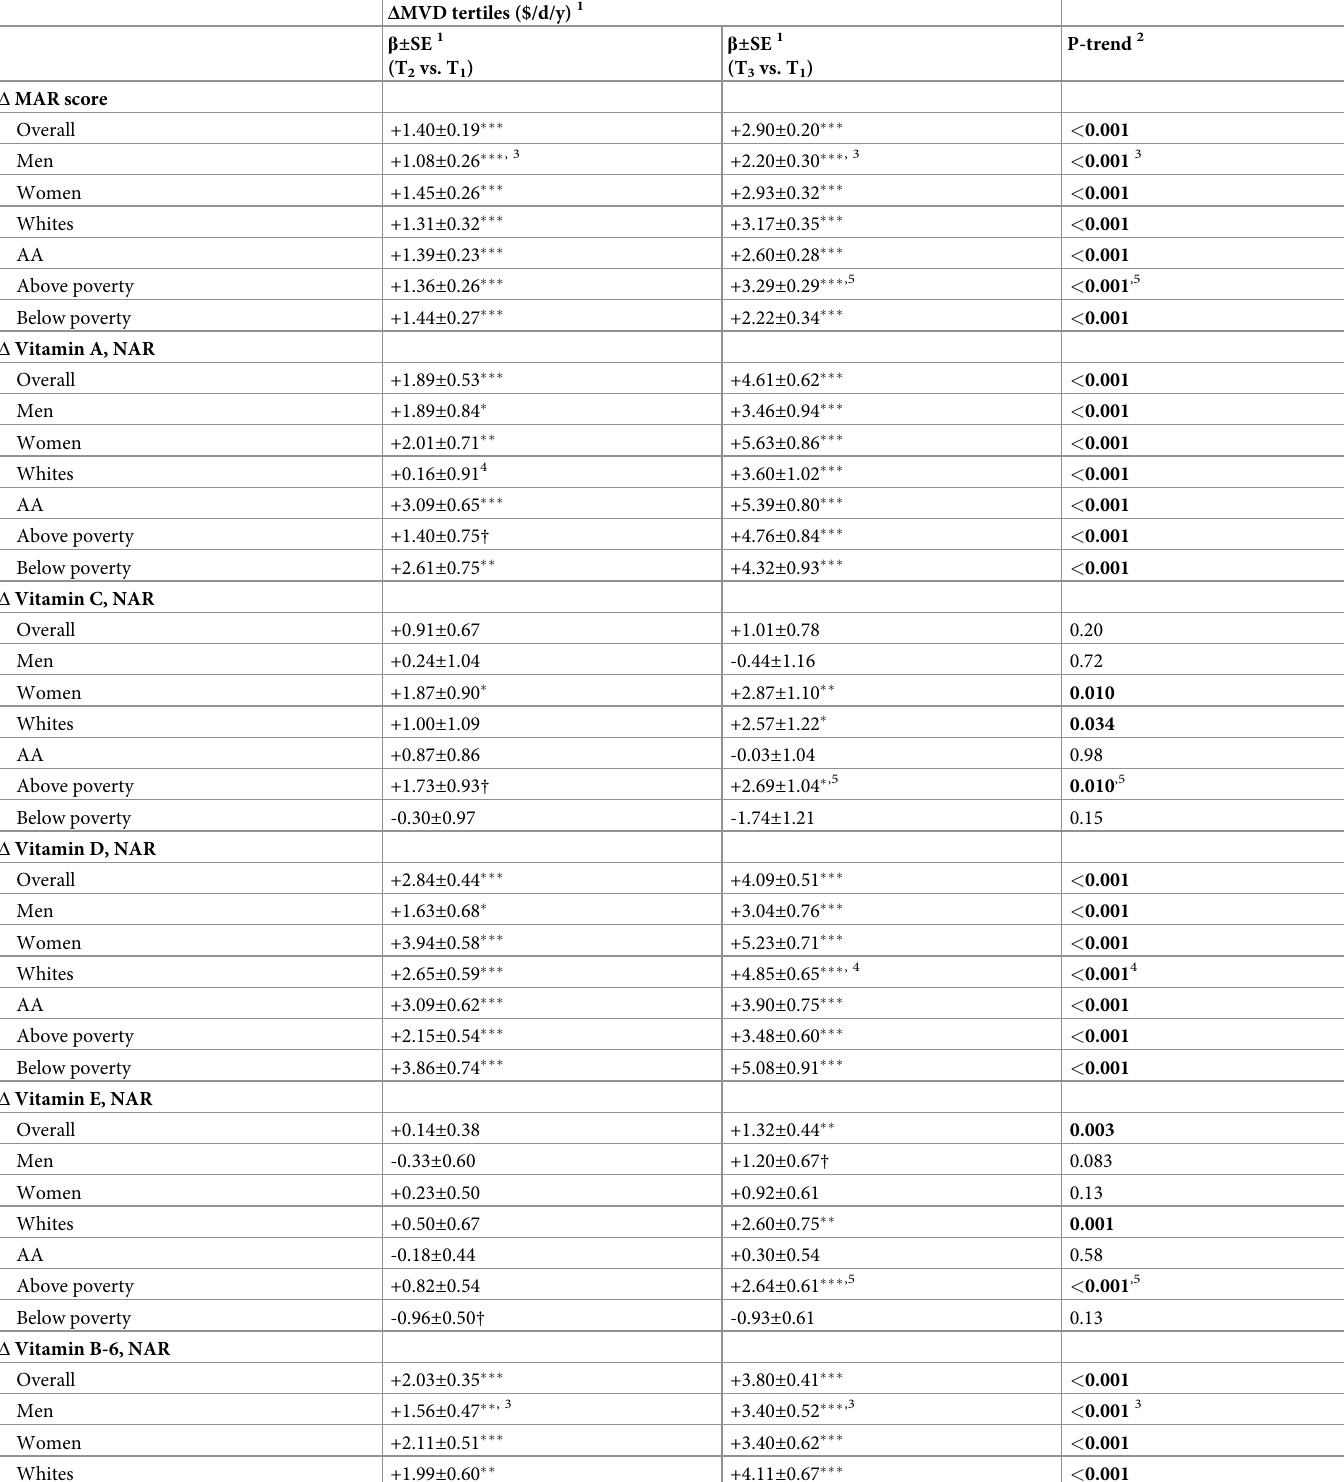
Table 3. Annual rate of change in MVD tertiles as predictors of annual rate of change in MAR and NAR, stratifying by sex, race and poverty status: Multiple ordi- nary least square regression models, HANDLS 2004 − 2013 5